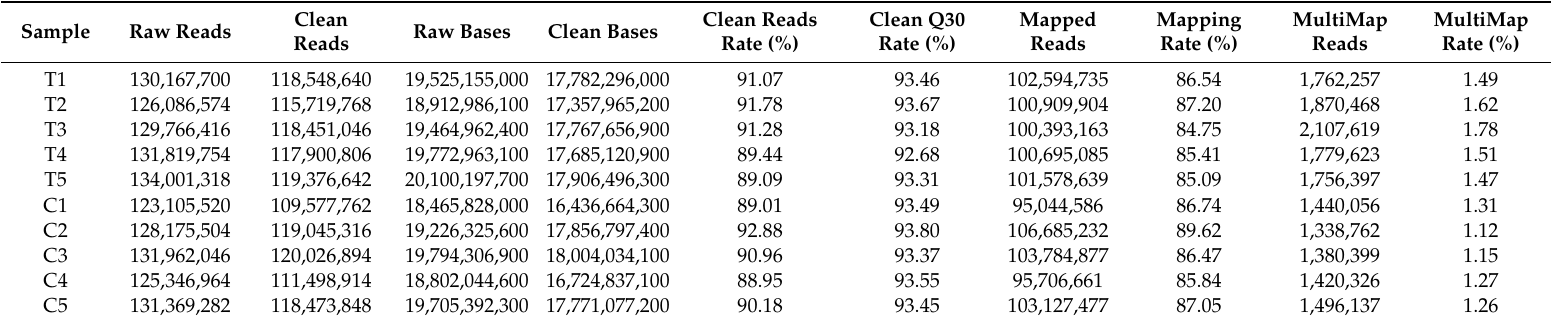
Table 1. Output statistics and annotation information of the sequencing reads for each